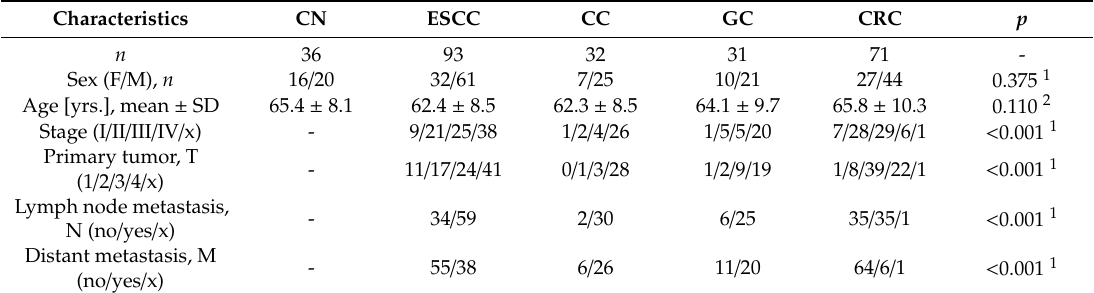
Table 11. Characteristics of study population for analysis of systemic interleukin concentration.